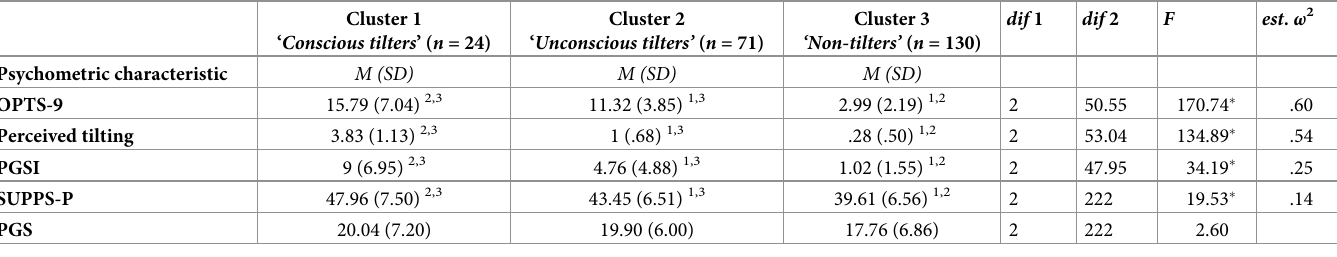
Table 3. Comparisons of the characteristics between the three